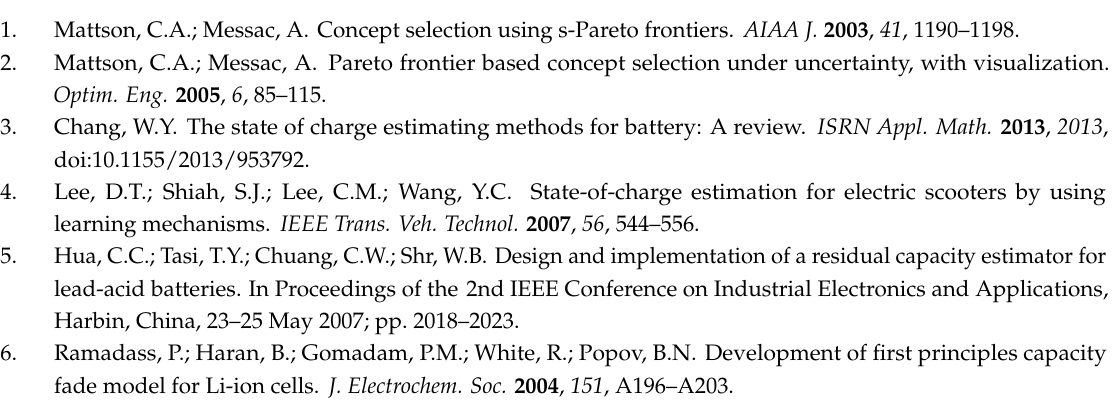
Table 5. Values of each parameter of the chosen solution ( θ C 2